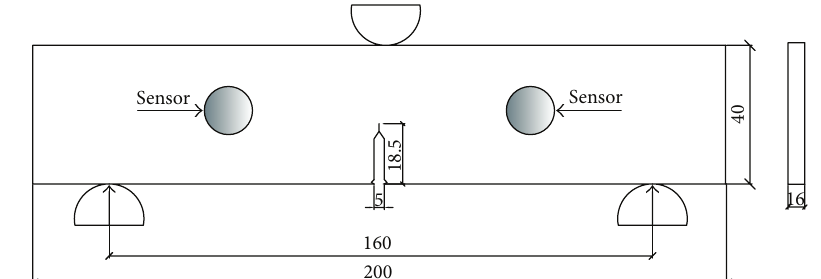
Figure 1: Specimen geometry.